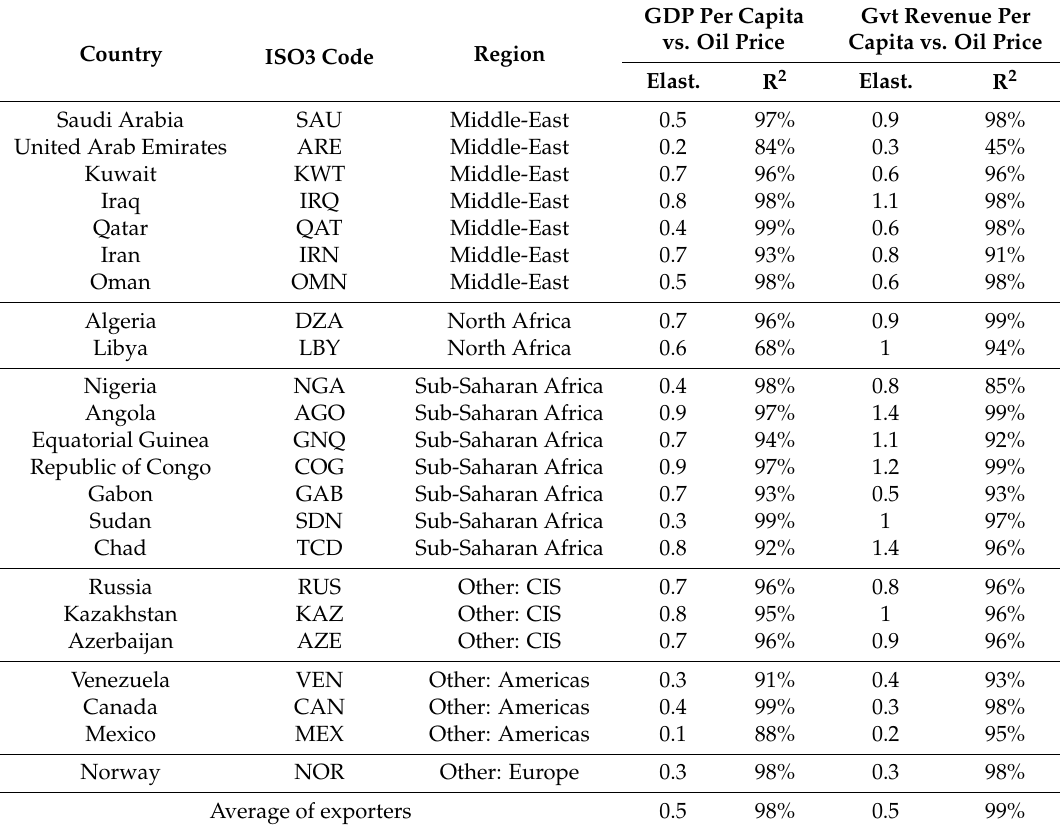
Table 3. Regression of GDP and government revenue (per capita) to oil price. Source: oil price is from BP (2015), oil exports are from BP (2015) and Enerdata (2016), GDP from World Bank (2016), government revenue from International Monetary Fund (IMF) (2015), and population from United Nations (UN)